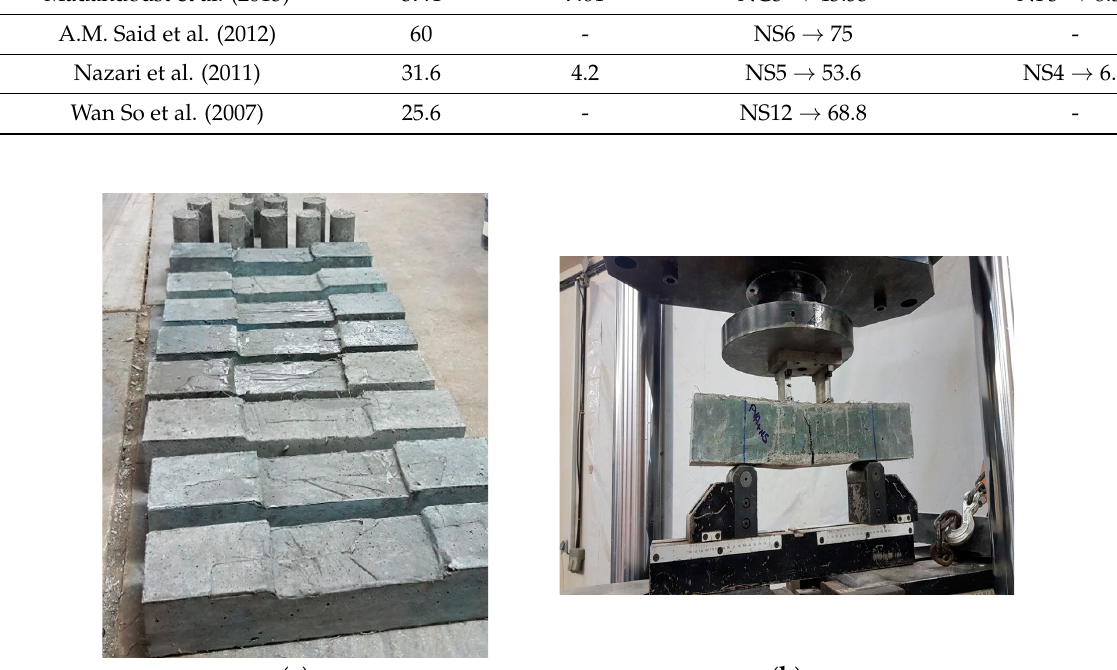
Figure 9. Compatibility of the specimens and the test setup [43]. ( a ) Preparation of specimens, ( b ) Test setup.